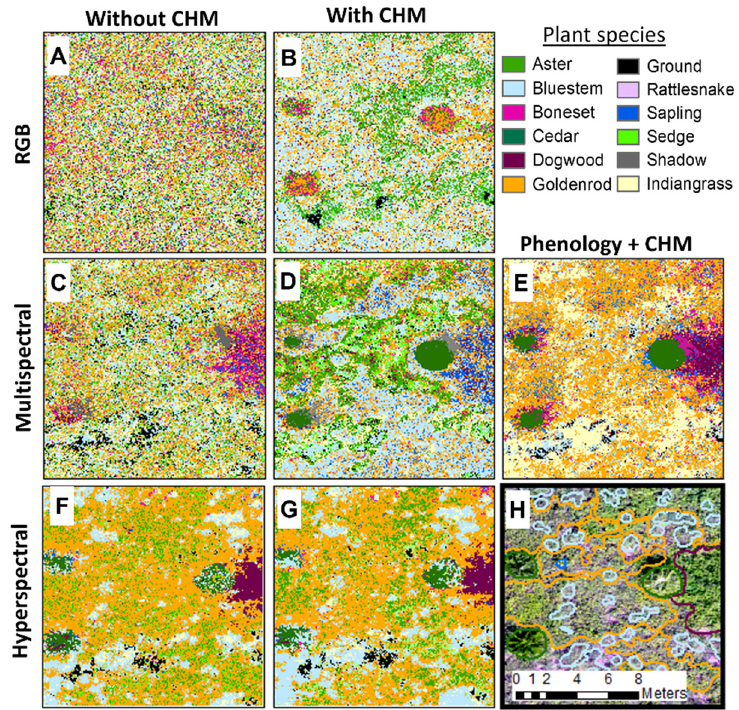
Figure 6. Example of random forest plant species maps. Panels represent RGB ( A ), RGB + CHM ( B ), Multispectral ( C ), Multispectral + CHM ( D ), Multispectral + CHM + Phenology ( E ), Hyperspectral ( F ), and Hyperspectral + CHM ( G ) orthorectified UAS RGB imagery superimposed by ground-delineated reference data by species ( H ). See Supplementary Material (Tables S1, S3, S5, S7, S9, S11 and S13) for species summaries of the entire study area derived from our top-performing UAS network.